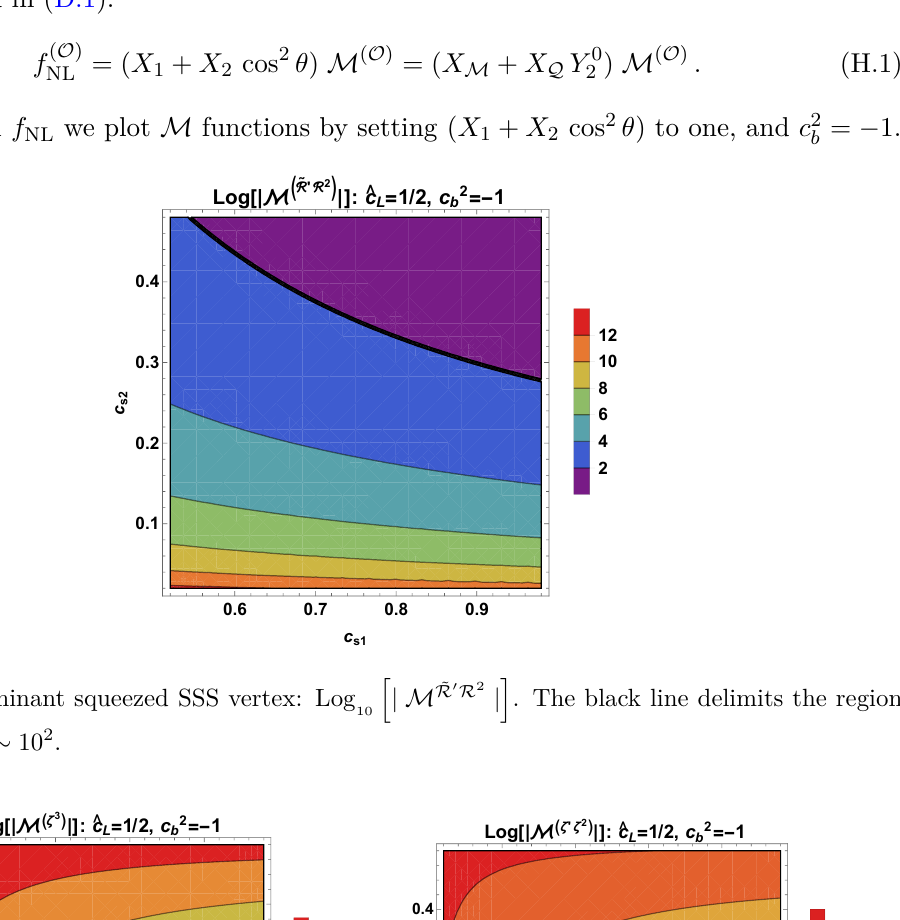
h | M ζ 3 n ,ζ 0 n ζ 2 n | 10